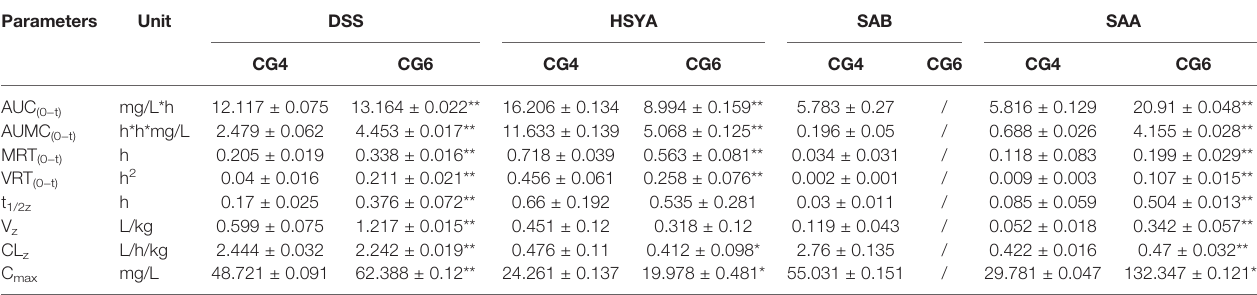
TABLE 3 | Pharmacokinetic parameters of danshensu (DSS), hydroxysaf fl or yellow A (HSYA), salvianolic acid B (SAB), and salvianolic acid A (SAA) in different groups ( n = 5). Parameters